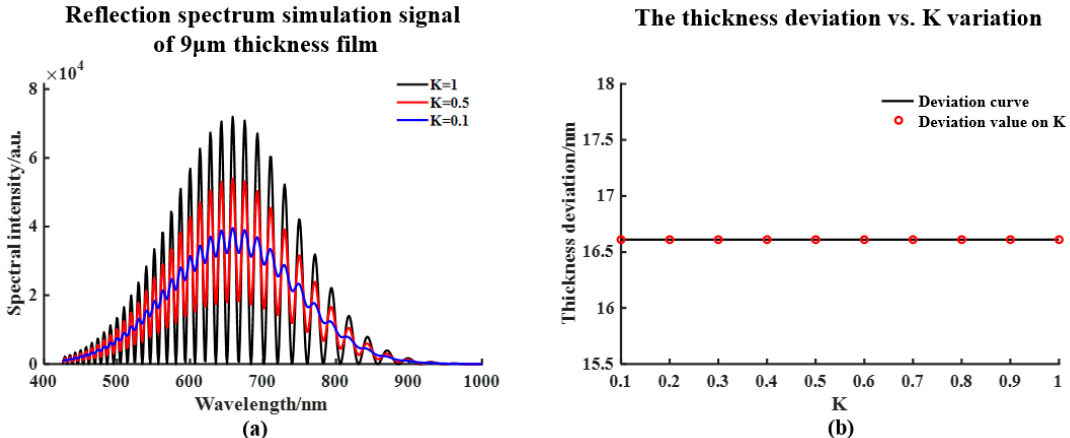
Figure 7. The influence of interference fringe contrast on the calculated thickness deviation. ( a ) The reflection spectrum simulation signal of 9 µ m thickness film when the contrast K is 0.1, 0.5, and 1. ( b ) The thickness deviation vs. K variation.